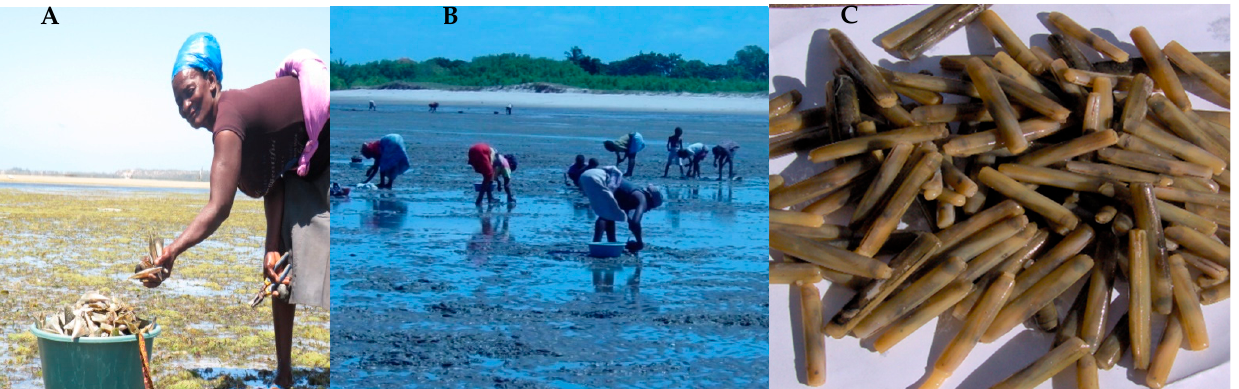
Figure 2. Harvesting Pinna muricata “mateo” with Pliers (IB) ( A ) and Solen cylindraceus “canivete” (western MB—( B , C )). Credits: Assucena Chissico ( A ), Salomão Bandeira ( B , C ) . Table 2. Causes of disturbance at the sites and estimate of average disturbed area per gleaner per day. Cr = Cymodocea rotundata ; Os = Oceana serrulata ; Ho = Halophila ovalis ; Hu = Halodule uninervis ; Tc = Thalassodendron ciliatum ; Zc = Zostera capensis . Disturbance level: + lowly disturbed; ++ moderately disturbed; +++ severely